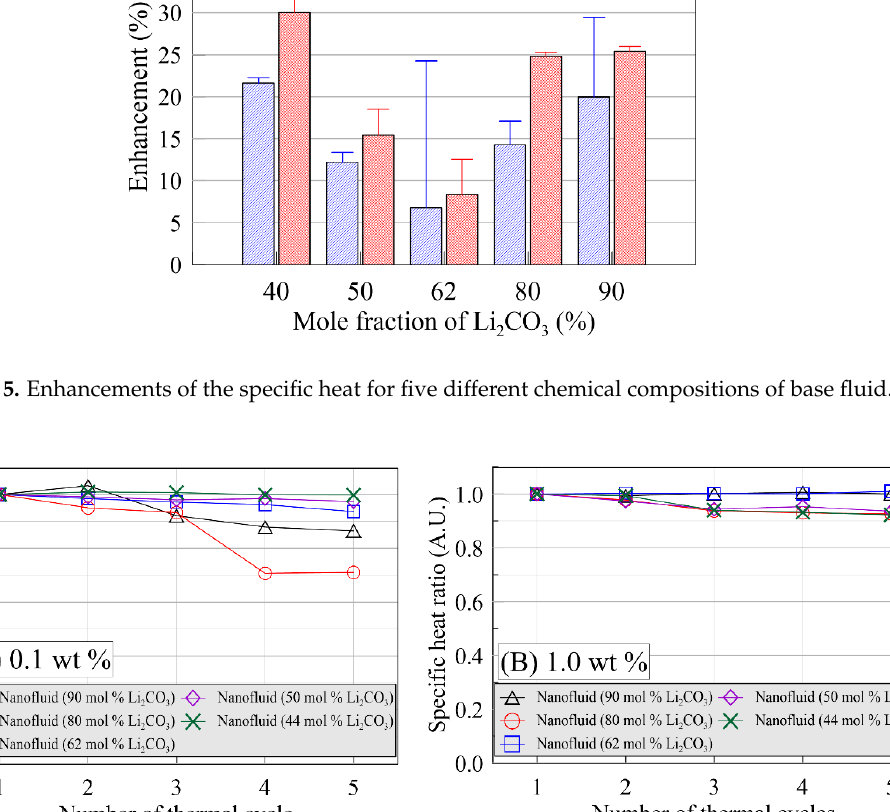
Figure 6. Change of specific heat ratio comparing to the first cycle measurement: ( A ) 0.1 wt % nanoparticle concentration; ( B ) 1.0 wt % nanoparticle concentration.